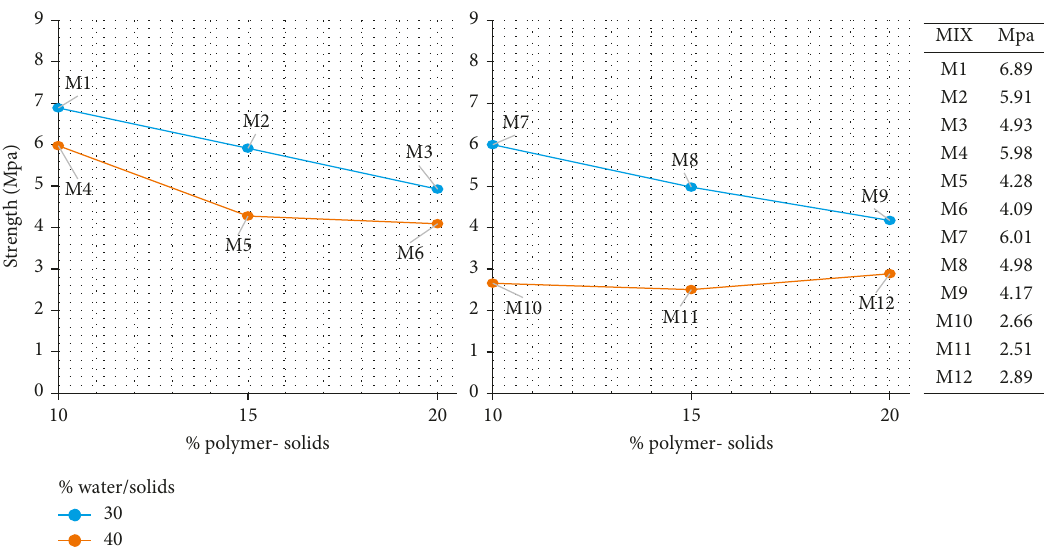
Figure 9: Compression resistance at 14 days (own